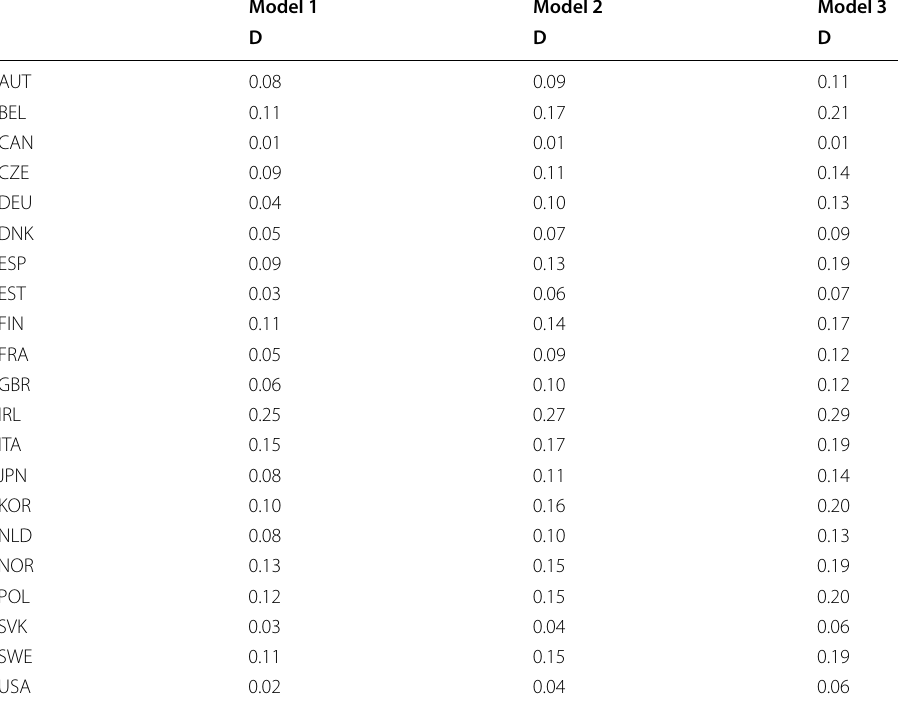
Model 1 Gender, Age, ParEd, # of books at home = Model 2 M1 Cognitive Skill (standardized Literacy & Numeracy = +